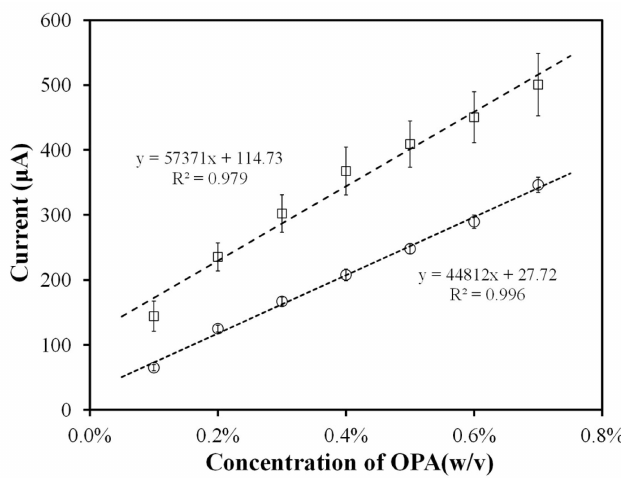
Figure 6. Calibration curve comparison between bare SPCE ( (cid:3) ) and pretreated SPCE ( chemically pre-treated SPCEs were activated in saturated Na 2 CO 3 at +1.2 V for 5 min. Batch determi- nation of OPA by amperometry (at +0.7 V) in 0.1 M PBS (pH 7.6) containing 50 mM glycine/30 mM NAC, with the concentration ranging from 0.2% to 0.6% ( w / v ) OPA, n =